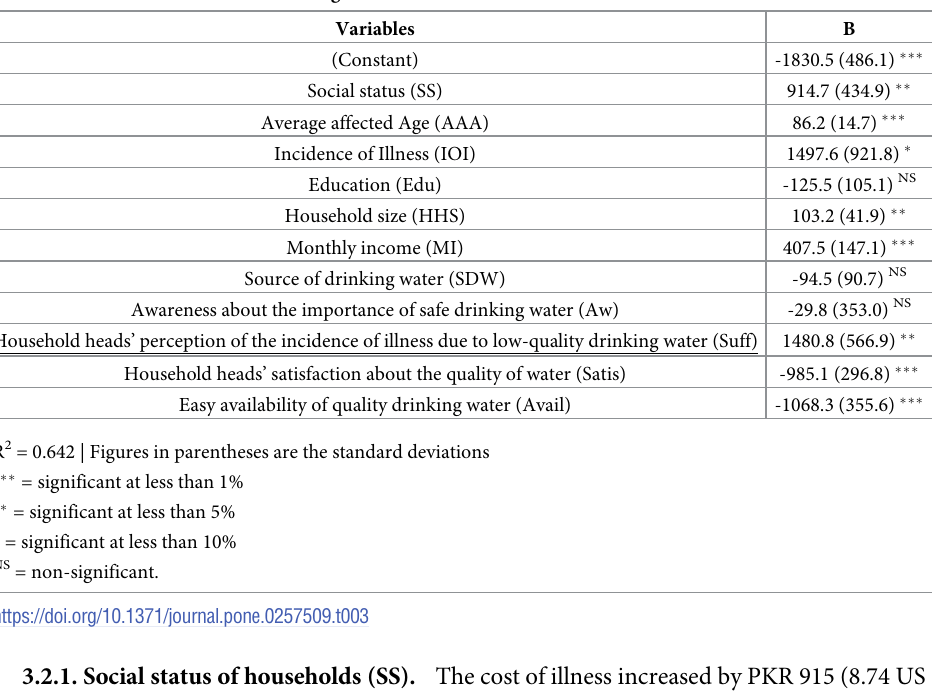
Table 3. Identification of factors affecting